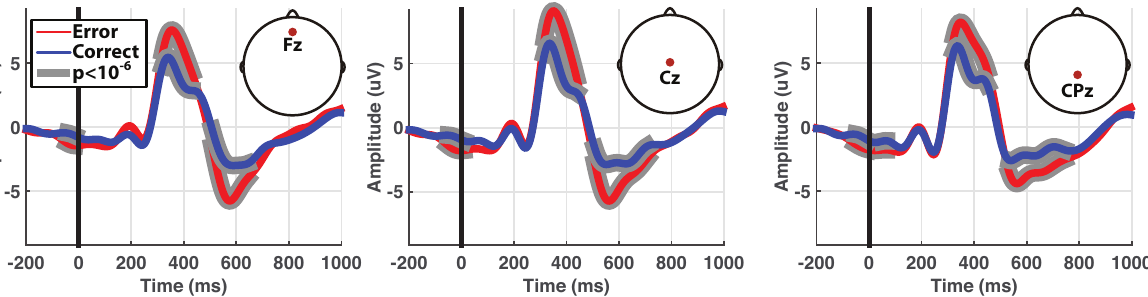
Fig 2. Grand-averaged signals for Fz, FCz and CPz channels. Red and blue lines represent averaged signals for the error and correct conditions respectively, where the movement onset is marked as time 0 ms. Statistical differences (unpaired t-tests, p-values < 1 (cid:4) 10 − 6 ) between error and correct averages are marked by shadowed